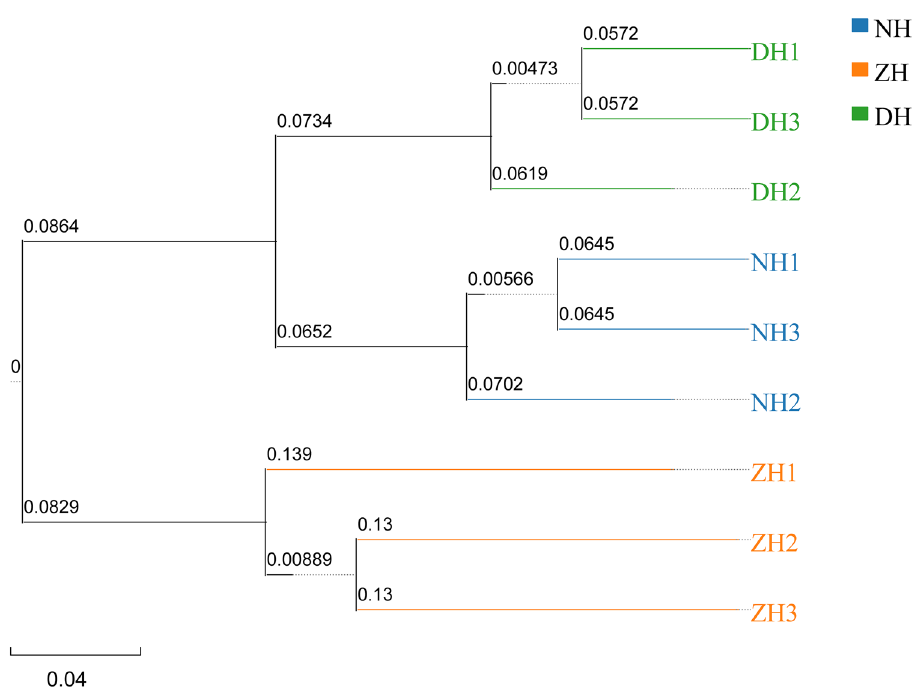
Figure 4. UPGMA cluster tree based on unweighted unifrac